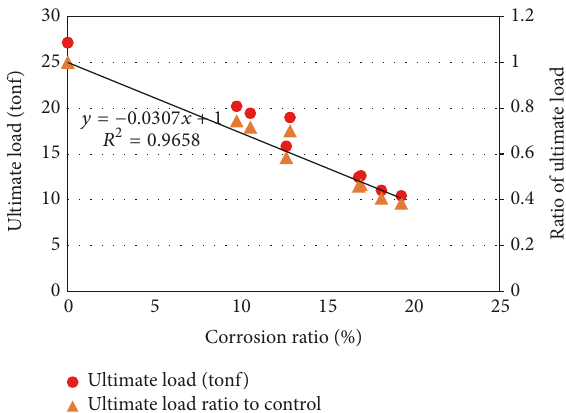
monitored after ICM test. The signal from load cell and gauge on the tendon surface out of corroded area (shown in Figure 2) are read in data logger. Although the strain gauge is attached on the twisted tendon out of corrosion area, stress- strain behavior can be approximately evaluated. The results are shown in Figure 8.